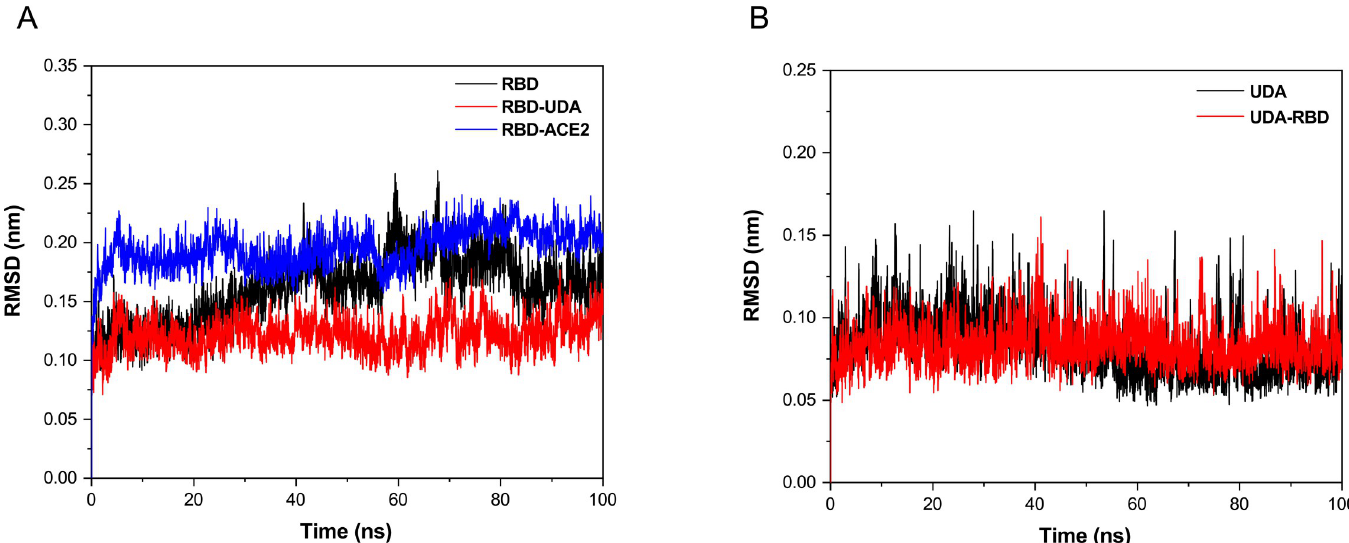
Fig 4. RMSD (backbone) plots for free RBD and RBD in the RBD-UDA, and RBD-ACE2 complexes (a). RMSD (backbone) of free UDA and UDA in the RBD-UDA complex during 100 ns of molecular dynamics simulation (b).